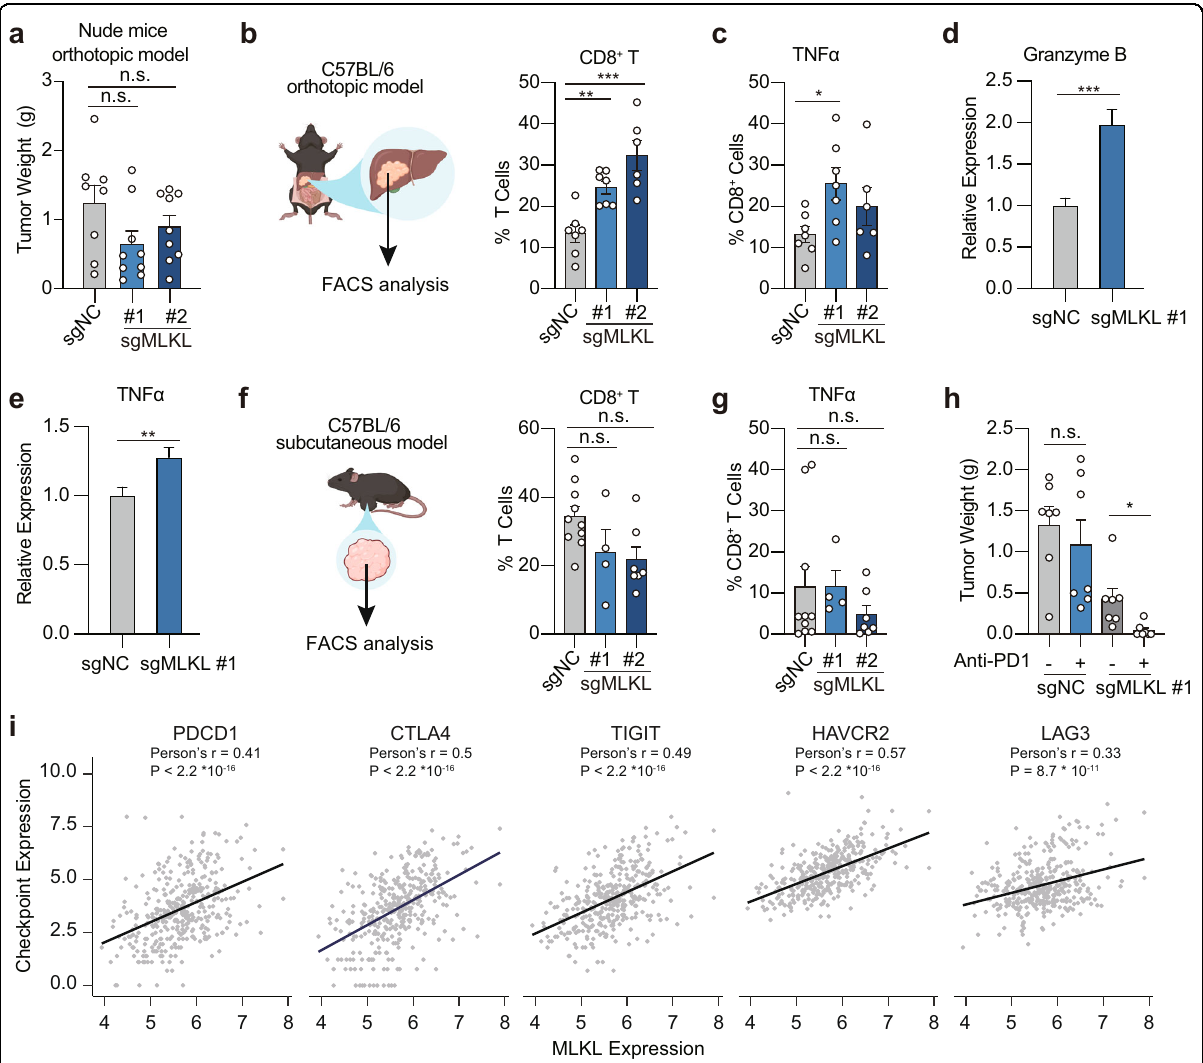
Fig. 2 MLKL de fi ciency activates anti-tumor immunity in HCC tumors. a Endpoint tumor weight of MLKL-KO and control murine HCC cells in nude mice. MLKL-KO Hepa 1 – 6-luc (sgMLKL) or control (sgNC) cells were orthotopically implanted in the liver of nude mice ( n = 8 for sgNC; n = 9 for sgMLKL #1 and sgMLKL #2). b , c Percentage of CD8 + T cells and TNF α + CD8 + T cells in orthotopic tumors. MLKL-KO and control cells as described in a were orthotopically implanted in the liver of C57BL/6 mice and tumor-in fi ltrating immune cells were analyzed. d , e Relative expression of Granzyme B and TNF α in tumor-in fi ltrating immune cells as described in b . f , g Percentage of CD8 + T cells and TNF α + CD8 + T cells in subcutaneous tumors. MLKL-KO and control cells as described in a were subcutaneously implanted in the right fl ank of C57BL/6 mice and tumor-in fi ltrating immune cells were analyzed. h Endpoint tumor weight upon treatment of anti-PD-1. Mice carrying MLKL-KO or control tumors as described in b were treated with anti-PD-1 antibody or isotype control antibodies every 3 days for 21 days ( n = 7). i Correlation between checkpoint expression and MLKL expression in HCC patients. Data were from TCGA public database. Data are represented as means ± SEM. Two-tailed Student ’ s t -test was used for statistical analysis. ns, not signi fi cant; * P < 0.05, ** P < 0.01, *** P <